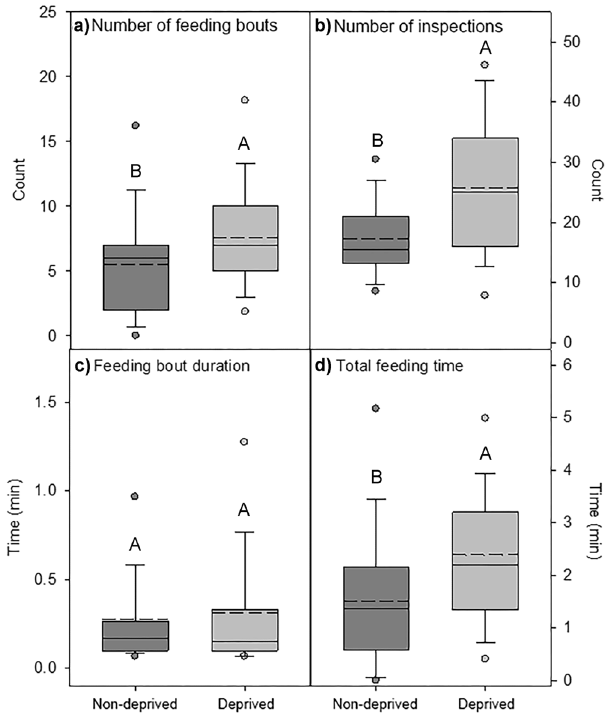
Figure 2. Figure shows nursing responses to side-by-side patches of deprived (light grey) and non-deprived (dark grey) larvae. Nurses generally attended deprived larvae with greater frequency over the observation period with a significantly greater number of ( a ) feedings (p = 0.001), ( b ) inspections (p < 0.001), and ( d ) longer total feeding time (p = 0.011). ( c ) Duration of individual feeding bouts were not significantly different between treatments (p = 0.881). Nursing responses were analyzed for a total of 6 larvae from each of the deprived and non-deprived groups and the data was pooled for each group (N = 2). For all variables with the same letter (A or B), the difference between the means is not statistically significant.